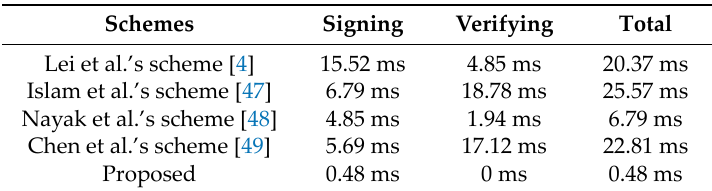
Table 3. Computational cost in milliseconds.